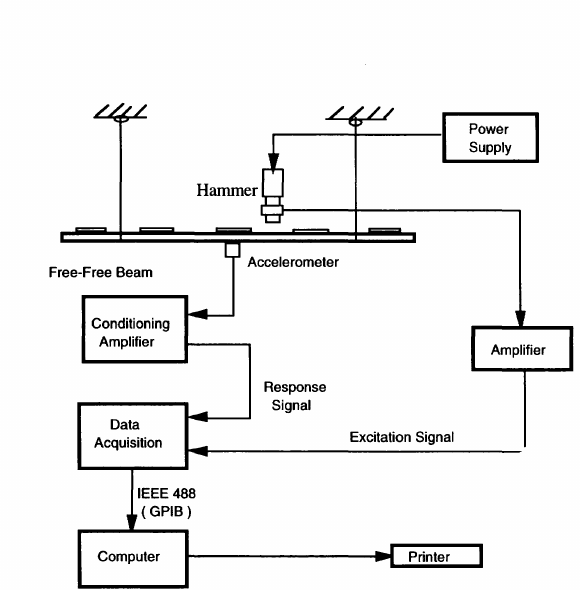
FIGURE 2 Apparatus for free-free vibration of